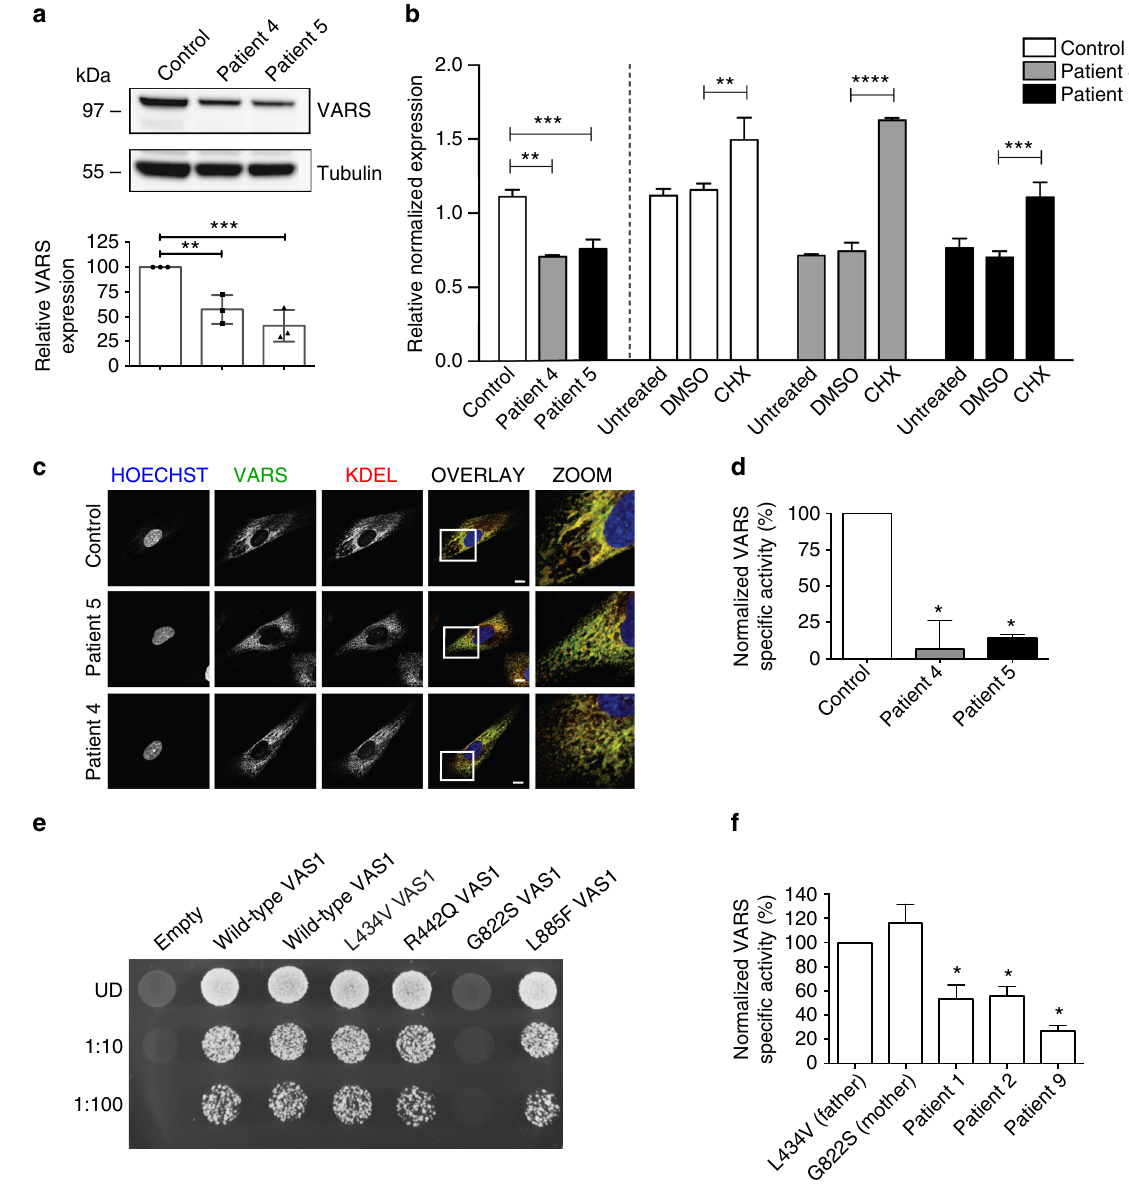
Fig. 2 In vitro studies support variant pathogenicity. a Western blot performed on patient-derived fi broblasts from patients 4 and 5 of family 3 carrying the L78Rfs*35/R942Q VARS variant showed almost 50% reduction in VARS protein. Values are mean of three separate experiments. Error bars represent SD. b RT-qPCR on the fi broblasts showed almost complete absence of the frameshift allele at mRNA level, treatment with cycloheximide caused a partial increase in expression of the frameshift allele, which was not seen with DMSO-treated control. Values are mean of three separate experiments performed in triplicate. Error bars represent SD. c Immunocytochemistry highlighted the nucleus (Hoechst), VARS and KDEL, a marker for endoplasmatic reticulum. VARS co-localizes with KDEL. There was no difference in localization between the control line and the patient fi broblasts. d VARS and TARS aminoacylation activity measured in extracts from the patient fi broblasts. The data were normalized to ATTC fi broblasts. VARS aminoacylation activity was measured in technical triplicate at three separate passages, and TARS activity was measured once in technical triplicate. Data are represented as mean- speci fi c activity and error bars represent SEM. * indicates signi fi cant difference from control. e A haploid yeast strain deleted for endogenous VAS1 was transformed with a LEU2 -bearing pRS315 vector containing wild-type VAS1 , the indicated mutant form of VAS1 , or no insert (empty). Cultures for each strain (labeled along the top) were either undiluted (UD) or diluted 1:10 or 1:100 and then spotted on solid medium containing 5-FOA to determine whether the VAS1 alleles complement loss of endogenous VAS1 at 30 °C. Only G822S shows absent growth indicating a functional null allele. f VARS and TARS aminoacylation activity measured in extracts from patient-derived lymphoblasts of patients 1 and 2 (L434V/G822S) and their parents and patient 9 (R404W). Data were normalized to the paternal cells. VARS aminoacylation activity was measured in technical triplicate at three separate passages, and TARS activity was measured once in technical triplicate. Data are represented as mean-speci fi c activity and error bars represent SEM. * indicates signi fi cant difference from L434V paternal lymphoid cells. In a , b , d , and f one-way ANOVA with Tukey ’ s multiple comparisons test was used. Signi fi cant values are noted ** p < 0.01, *** p < 0.001, and **** p <